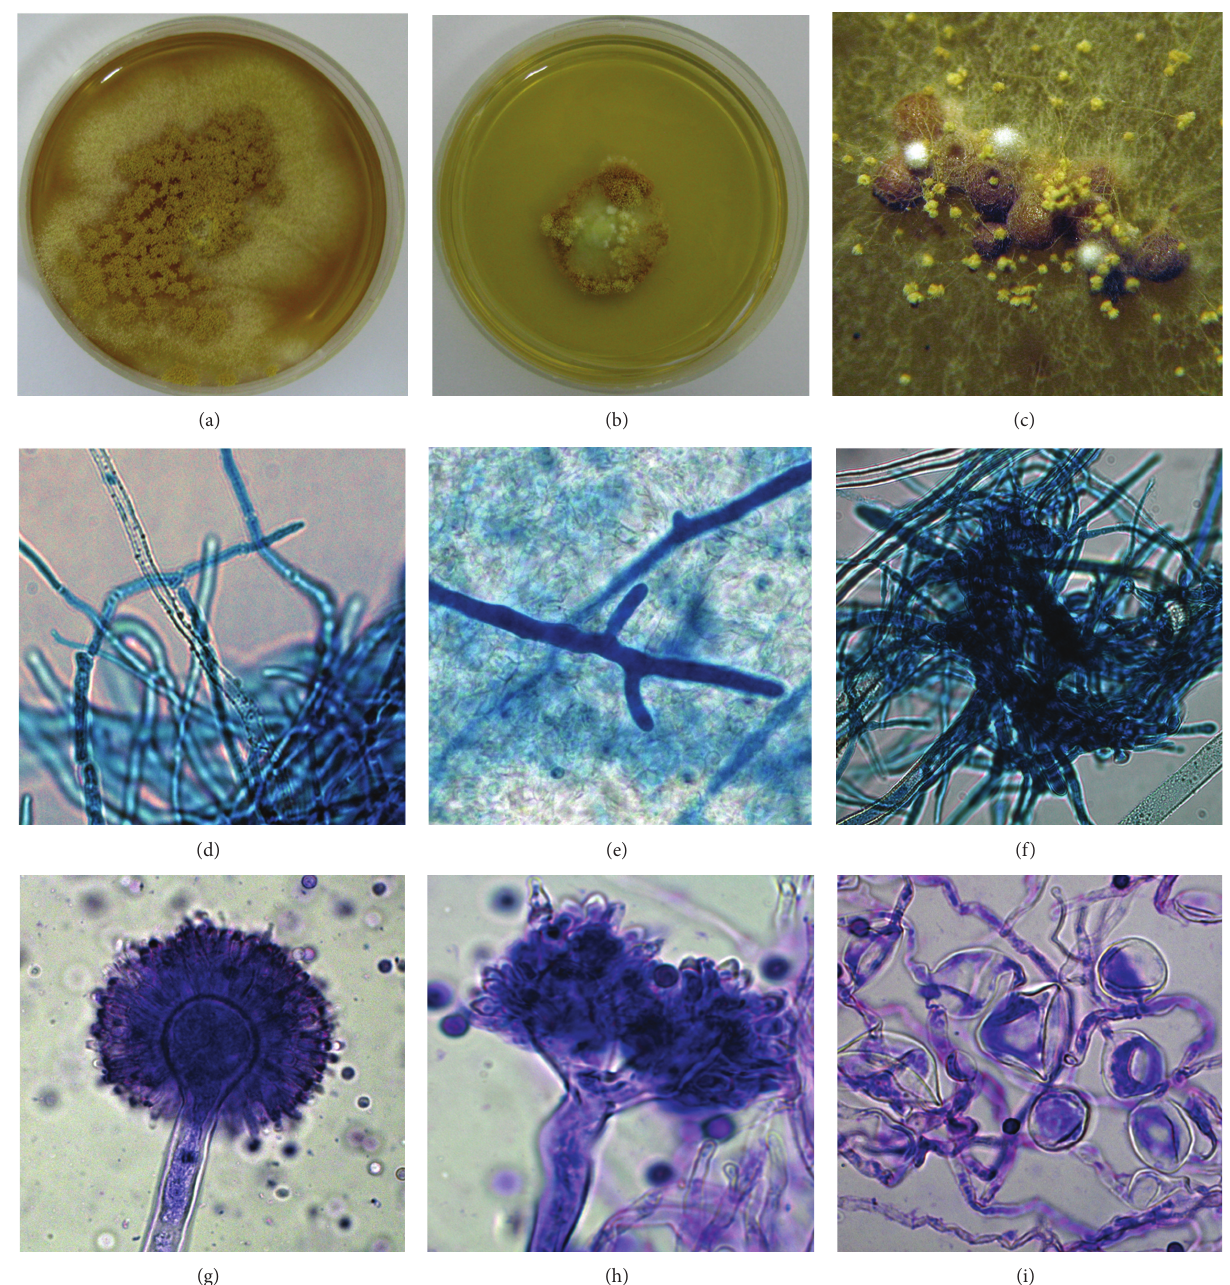
Figure 5: Morphophysiological alterations in 21-day-old Aspergillus ochraceus culture (MEA) induced by benzalkonium chloride (0.6 𝜇 gmL −1 ): control colony (a); altered colony morphotype (b); in situ sclerotia ( × 20) (c); typical hyphal morphology (control, × 630) (d); conspicuous “worm-like” hyphae in mycelial mass ( × 400) (e); initial stage of sclerotium formation in form of clamps of fragmented, thick- walled hyphae ( × 630) (f); normal conidial head (control, × 630) (g); bifurcate conidiophore with aberrant conidial heads ( × 630) (h); and distorted hyphae with intercalary and apical swellings ( × 630)